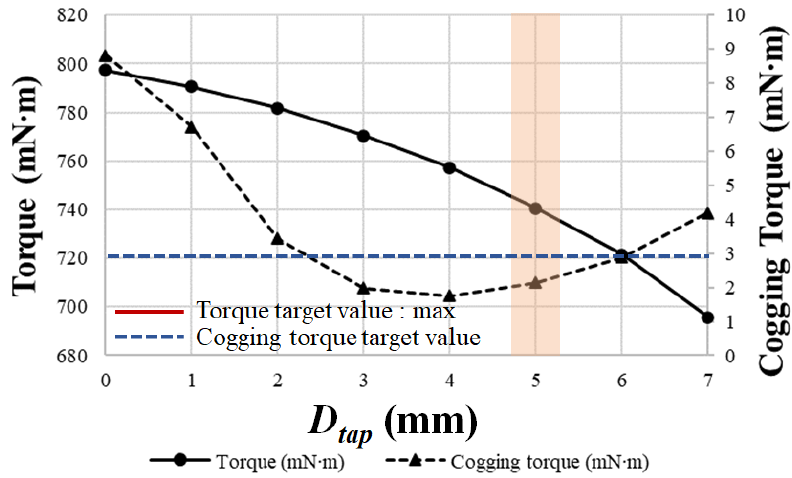
Figure 15. Torque and cogging torque variation with D tap (4000 rpm).